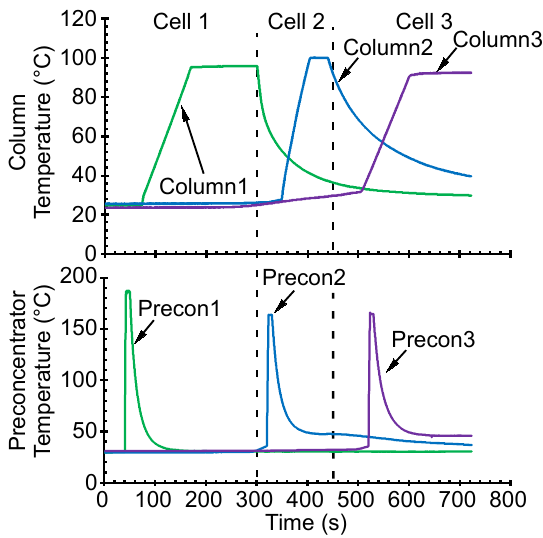
Figure 7. Temperature control for the preconcentrators and the separation columns. Initial tests were directed at the collection and separation of alkanes C 5 –C 15 with a concentration of 100 ppb; typical results are presented in Figure 8. The alkanes C 5 –C 7 were retained and separated in Cell 2, and alkanes C 8 –C 15 were separated in Cell 3. Other tests were directed at alcohols, in particular, methanol, ethanol, IPA, and butanol; and phosphonate esters, in particular, dimethyl methylphosphonate (DMMP) and diethyl methylphosphonate (DEMP)—all at a concentration of 1 ppm. Typical results are presented in Figure 9. Methanol, ethanol, and IPA were separated in Cell 1; 1-butanol and DMMP were separated in Cell 2; 1-butanol and DEMP were separated in Cell 3. Yet other tests were directed at ketones (acetone and butanone) and aromatics (benzene, toluene, ethylbenzene, o-xylene, and mesitylene)—all at a concentration of 200 ppb; typical results are presented in Figure 10. Acetone was separated in Cell 1; 2-butanone, benzene, toluene, and ethylbenzene were separated in Cell 2; toluene, ethylbenzene, o-xylene, and mesitylene were separated in Cell 3. The volatility of each of the tested analytes is represented by its Kovats retention index (RI), which is an indicator of the analyte retention time relative to n -alkanes [31]. The RI for the tested analytes ranged from 370 to 1500.